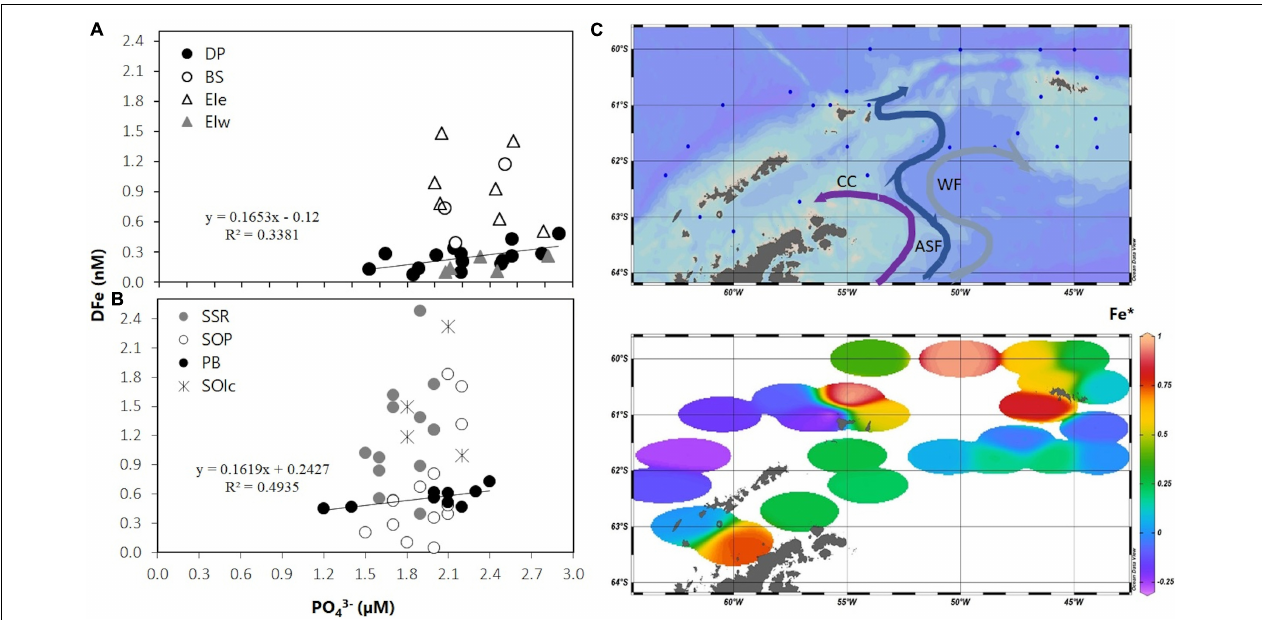
FIGURE 9 | DFe (nM) in relation to phosphate ( µ M) for all groups of stations in (A) the SSI 2007 and (B) the SOI 2008. (C) Distribution of Fe ∗ for the surveyed area based on mean DFe and PO 43 − concentrations in the UML. Antarctic Slope Front (ASF) and Weddell Front (WF) schematic flow paths are depicted in the upper section. DP: Drake Passage area, BS: Bransfield Strait area, EIe: East Elephant Island area, EIw: West Elephant Island area, SSR: South Scotia Ridge, SOP: South Orkney Plateau, PB: Powell Basin, SOIc: South Orkney Islands